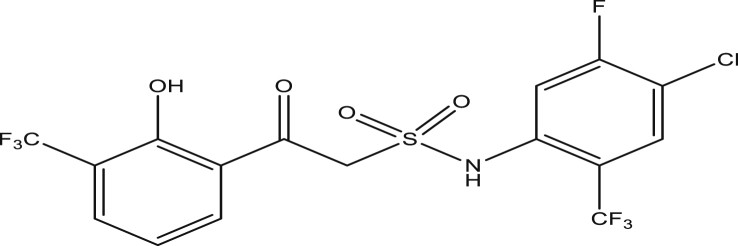
Compound 9i [N-(4-chloro-5-fluoro-2-(trifluoromethyl)phenyl)-2-(2-hydroxy-3-(trifluoromethyl)phenyl)-2-oxoethanesulfonamide (pEC500.2065013)].